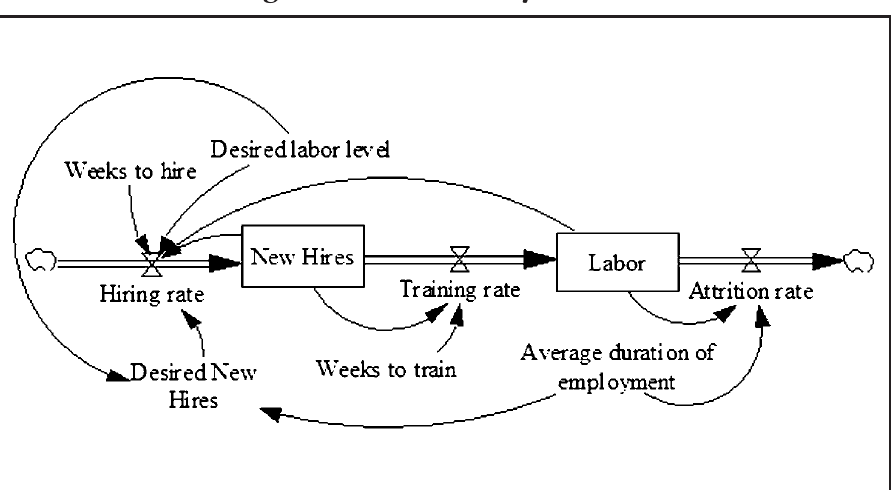
Figure 5. Accounts Payable Sector